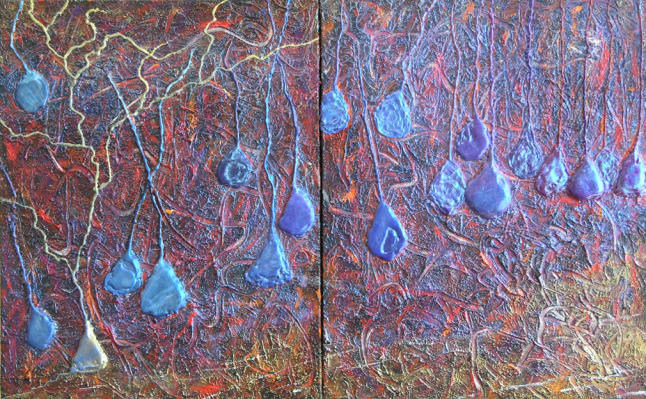
An acrylic painting by Don Cooper and Leah Leverich shows the transition zone between the densely packed pyramidal neurons in the CA1 region (right) and the spread-out pyramidal neurons within the subiculum (left)